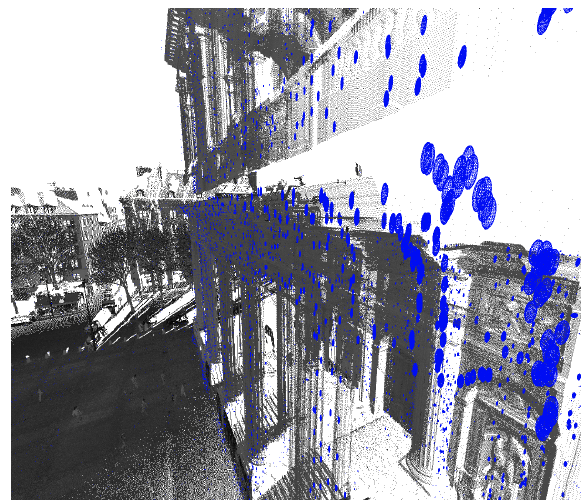
Figure 4: Black : points cloud of the mobile terrestrial LiDAR , blue : error ellipsoids. An error ellipsoid every 300 points